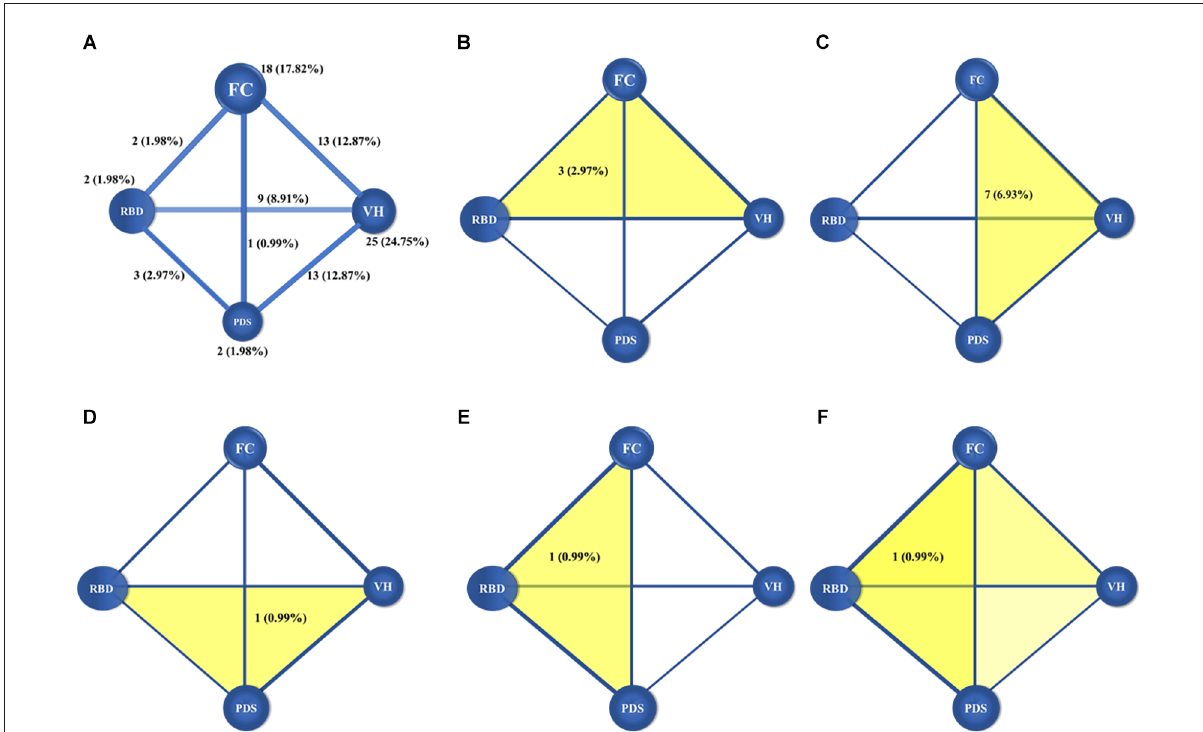
FIGURE3 Figures showed the number and proportions of DLB cases with one and two (A) core clinical features, three core clinical features (B–E) and four core clinical features (F) . The balls meant the core clinical features, and the lines and yellow patterns meant the combinations of core clinical features. In panel (A) , the numbers and proportions in the balls meant the distributions of individual core clinical feature, and the numbers and proportions in the lines meant the combinations of any two core clinical features. In panels (B–E) , the numbers and proportions in the yellow patterns meant the combinations of any three core clinical features, and in panel (F) , the number and proportion in the yellow patterns meant the combinations of four core clinical features. DLB, dementia with Lewy bodies; FC, fluctuating cognition; PDS, Parkinsonism; VH, visual hallucination; RBD, rapid eye movement sleep behavior